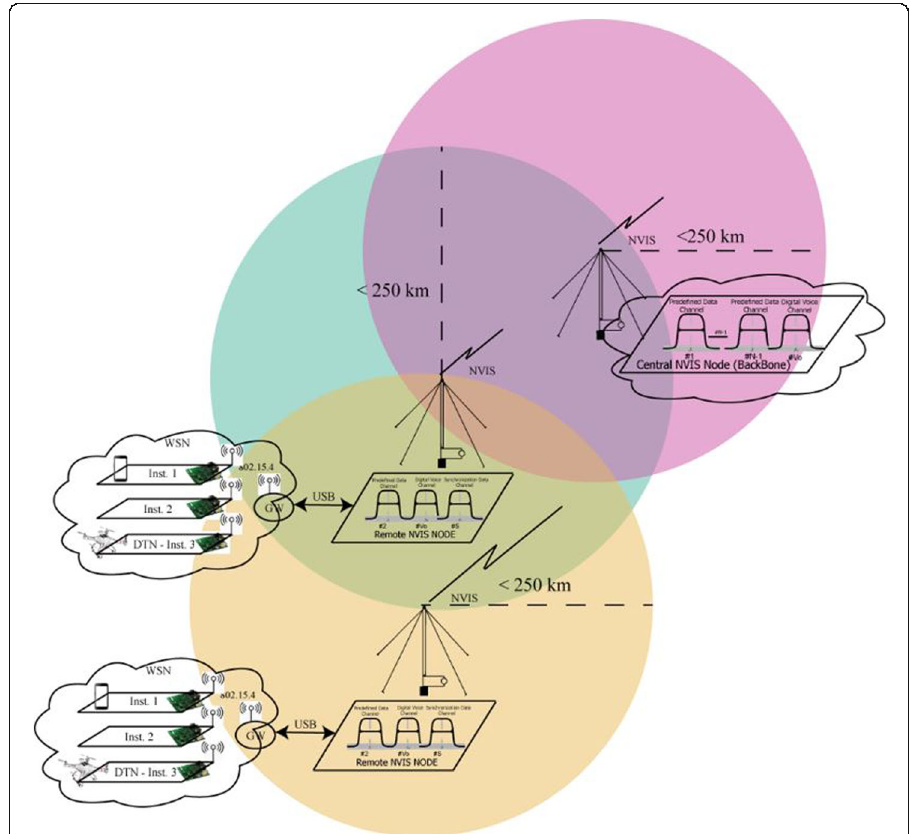
Fig. 15 Backhaul network. The coverage area of a possible backhaul network distribution. We can see how a remote node situated more than one hop to the central node can send the WSN data